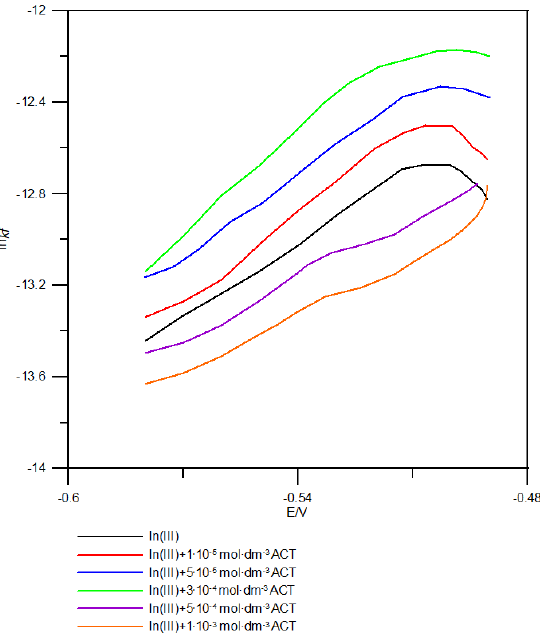
Figure 7. Dependence of the rate constants 𝑘 𝑓 of 1 mol · dm − 3 In(III) ions electroreduction in the